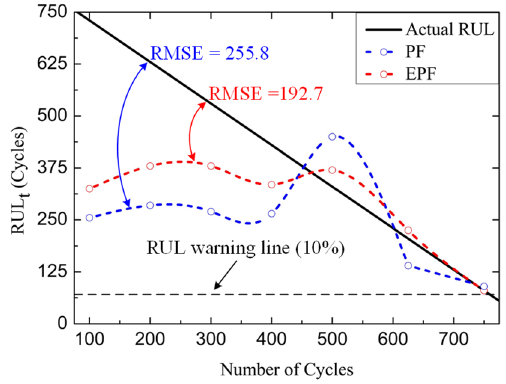
Figure 13. The estimated RUL trajectories based on the EPF and PF.